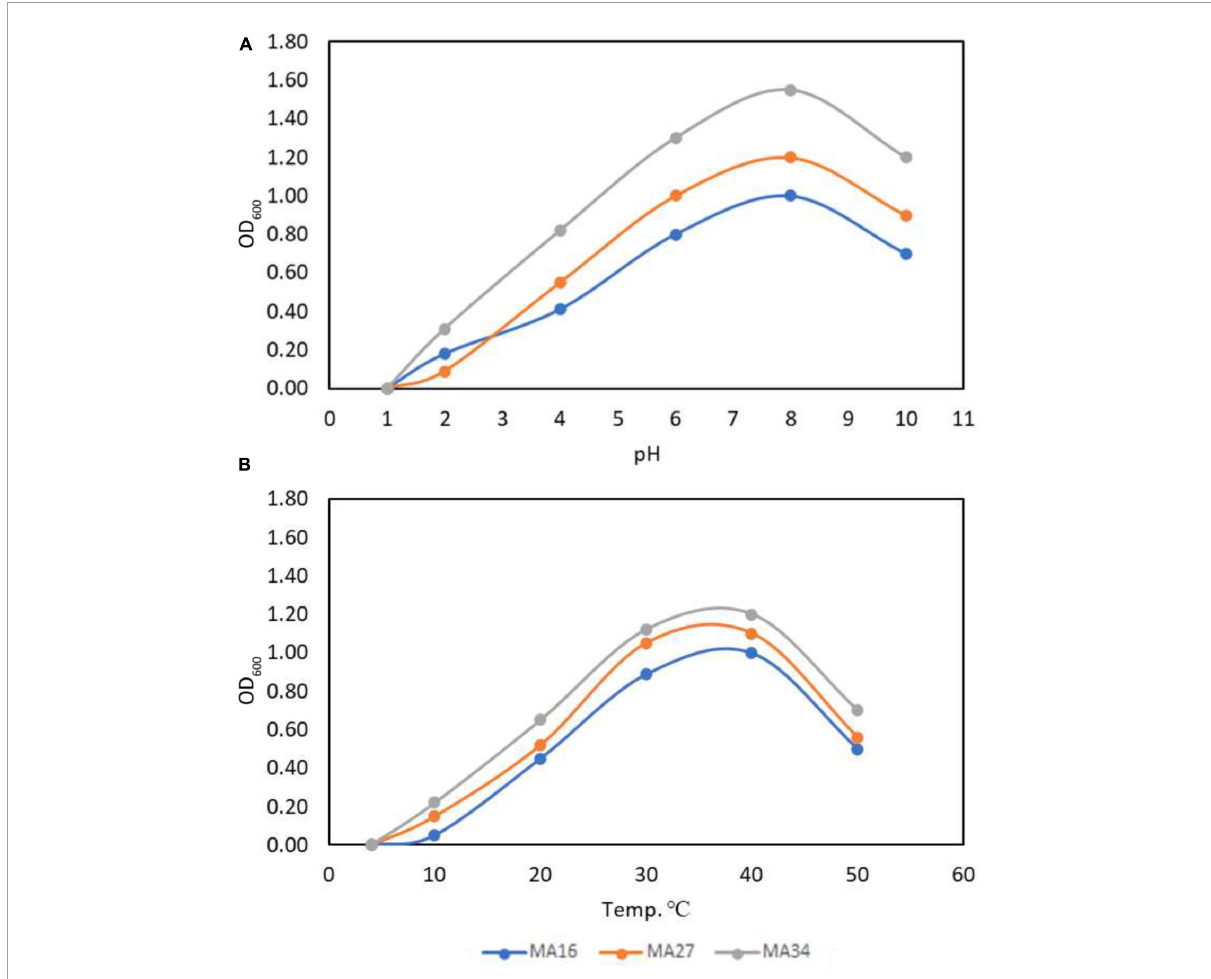
FIGURE1 Optimization of calcium carbonate precipitating bacteria (CCPB). Effect of (A) pH and (B) temperature on Bacillus lichenforms (MA16), Bacillus megaterium (MA27), and Bacillus subtilis (MA34)